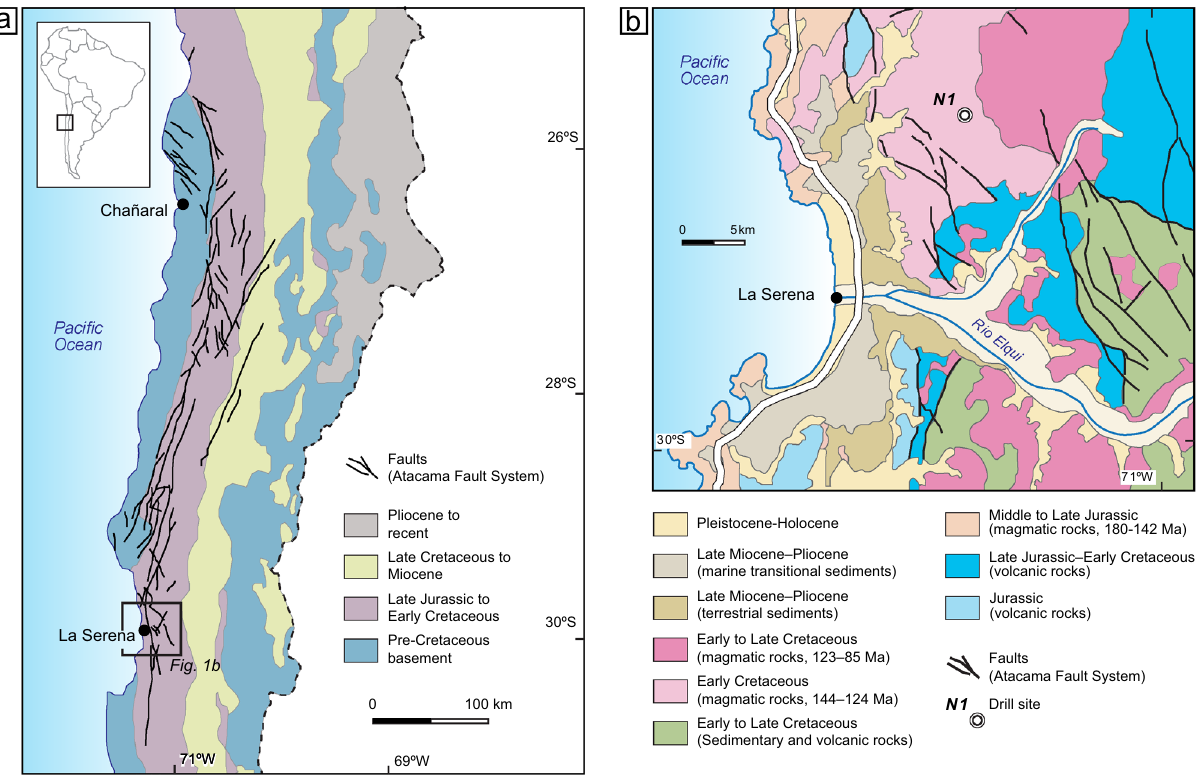
Figure 1. ( a ) Simplified geological map of northern Chile between 25 °S and 31 °S indicating the Atacama Fault System in the present-day forearc as based on maps in Tornos et al. 61 . Traces of the Atacama fault system are based on Cembrano et al. 31 . The study area near La Serena is indicated by the black rectangle. ( b ) Simplified geological map of the study area near La Serena as based on SERNAGEOMIN 30 . The NW- and N-trending faults are features of the southernmost part of the Atacama Fault